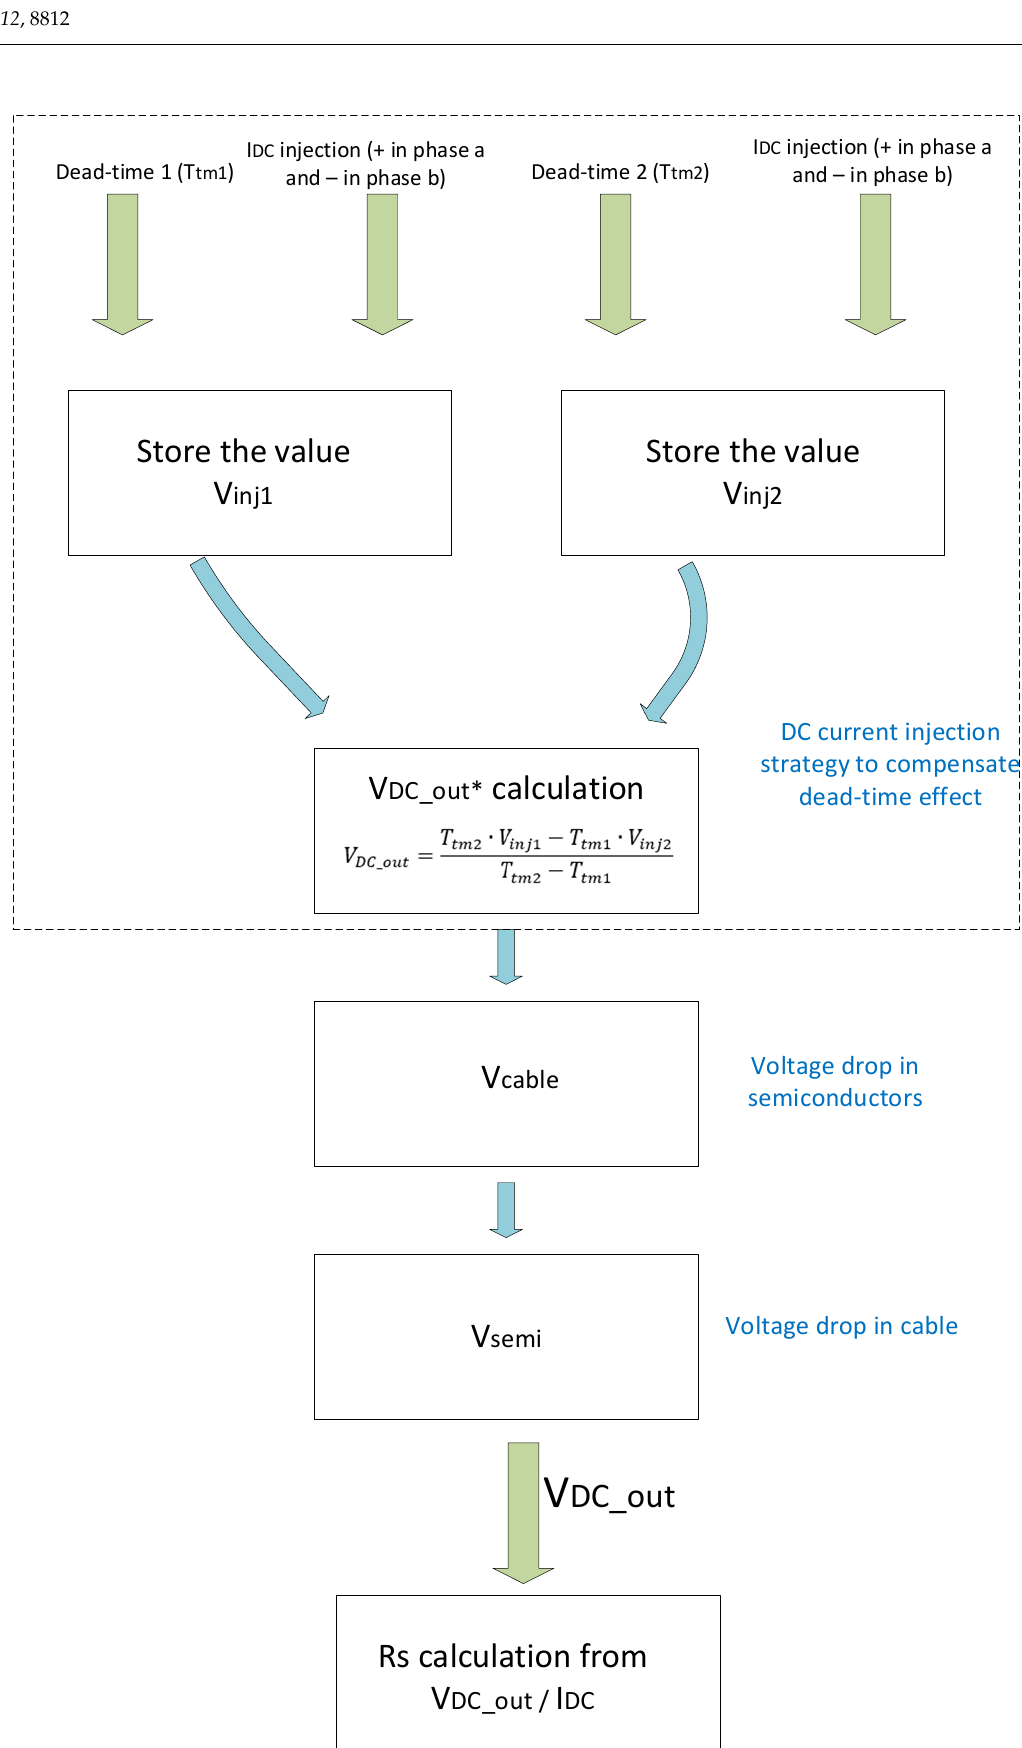
Figure 3. Double dead-time injection strategy to compensate dead-time effect.